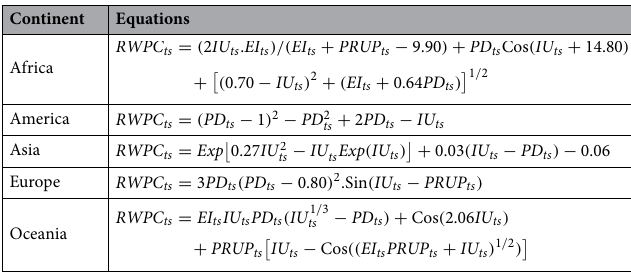
Table 10. Mathematical equations governing hydro-social